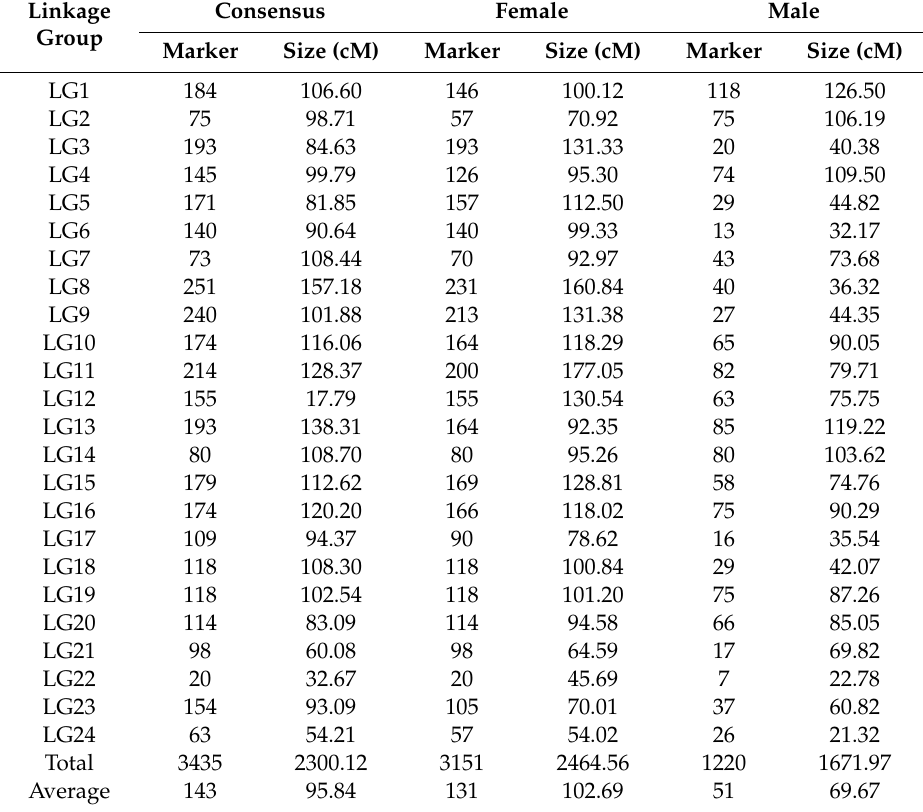
Table 1. Information on marker numbers and map lengths of di ff erent linkage groups (LGs) in the red-spotted